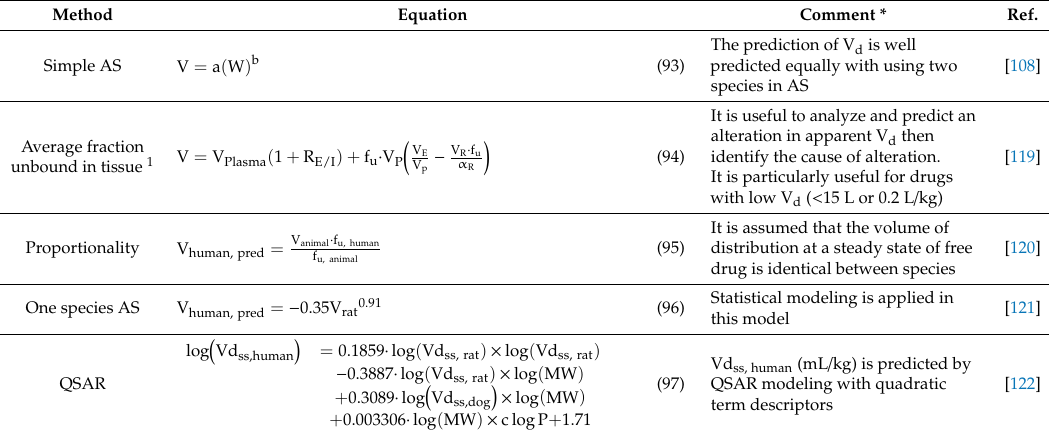
Table 4. Methods for prediction of volume of distribution (V d